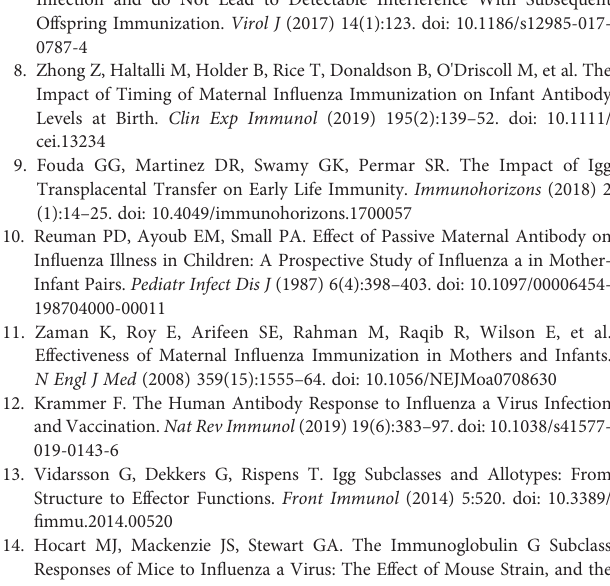
Supplementary Figure 1 | (A) Schematic comparison of the immunology of pregnancy in humans versus mice. (B) IgG1 antibody levels of naïve 6-8-week-old male (n=7-13) and female (n=5-7) offspring born to control (n=5) and IAV-infected dams (n=6) Unpaired Student T-test **p<0.005. (C) IgA antibody levels in BALF and lungs of offspring from CTLm (n=9), IAVm (n=3), PreC-IAVm (n=5), CTLm dam + IAVm offspring (n=6), IAVm dam + CTLm offspring (n=5). Unpaired Student T-test **p <